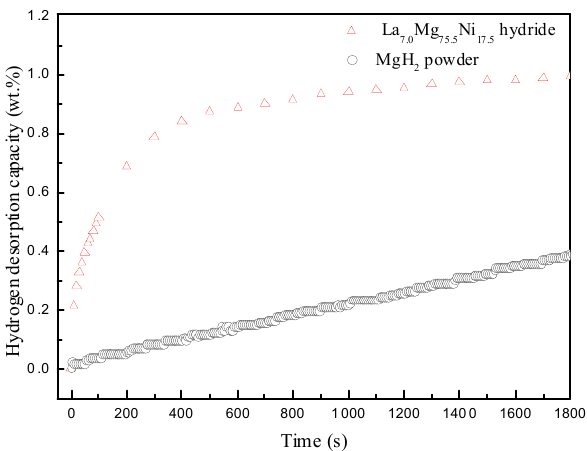
Figure 7. Dehydriding kinetics of the La 7.0 Mg 75.5 Ni 17.5 alloy and MgH 2 at 573 K.